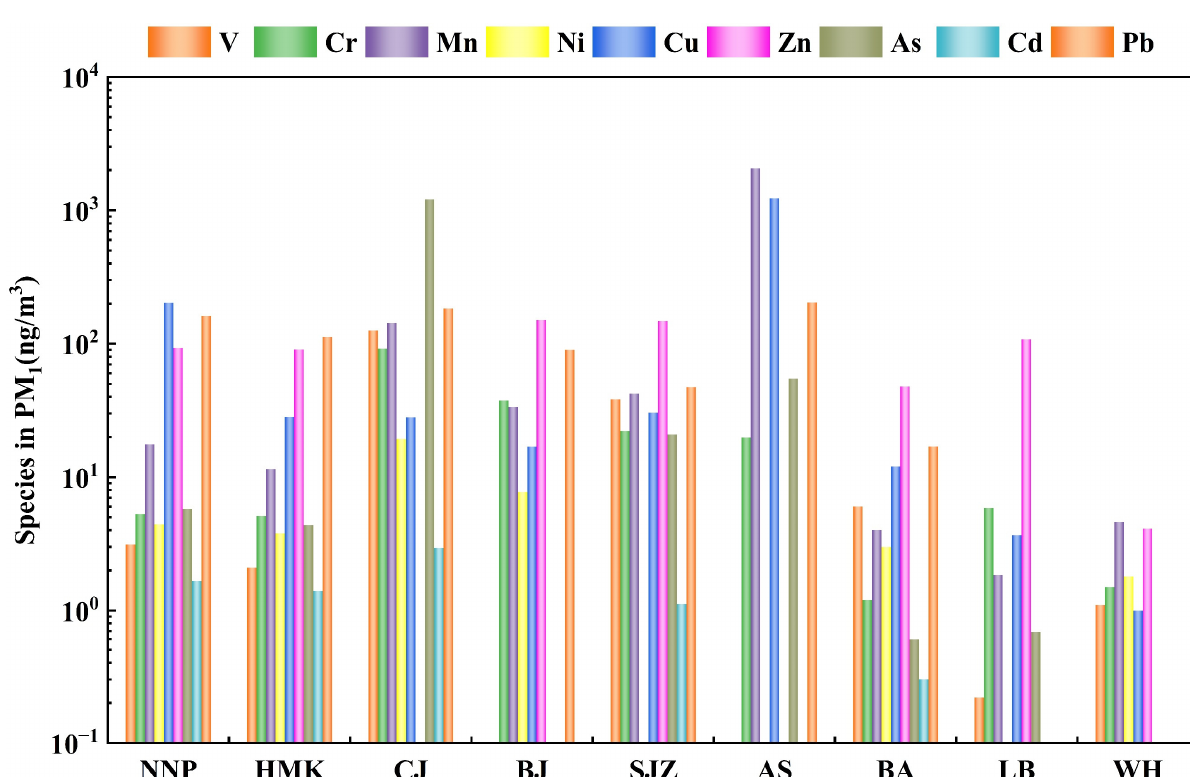
Figure 8. Average concentrations of PTEs in PM 1 in different cities. NNP, HMK: Panzhihua, China